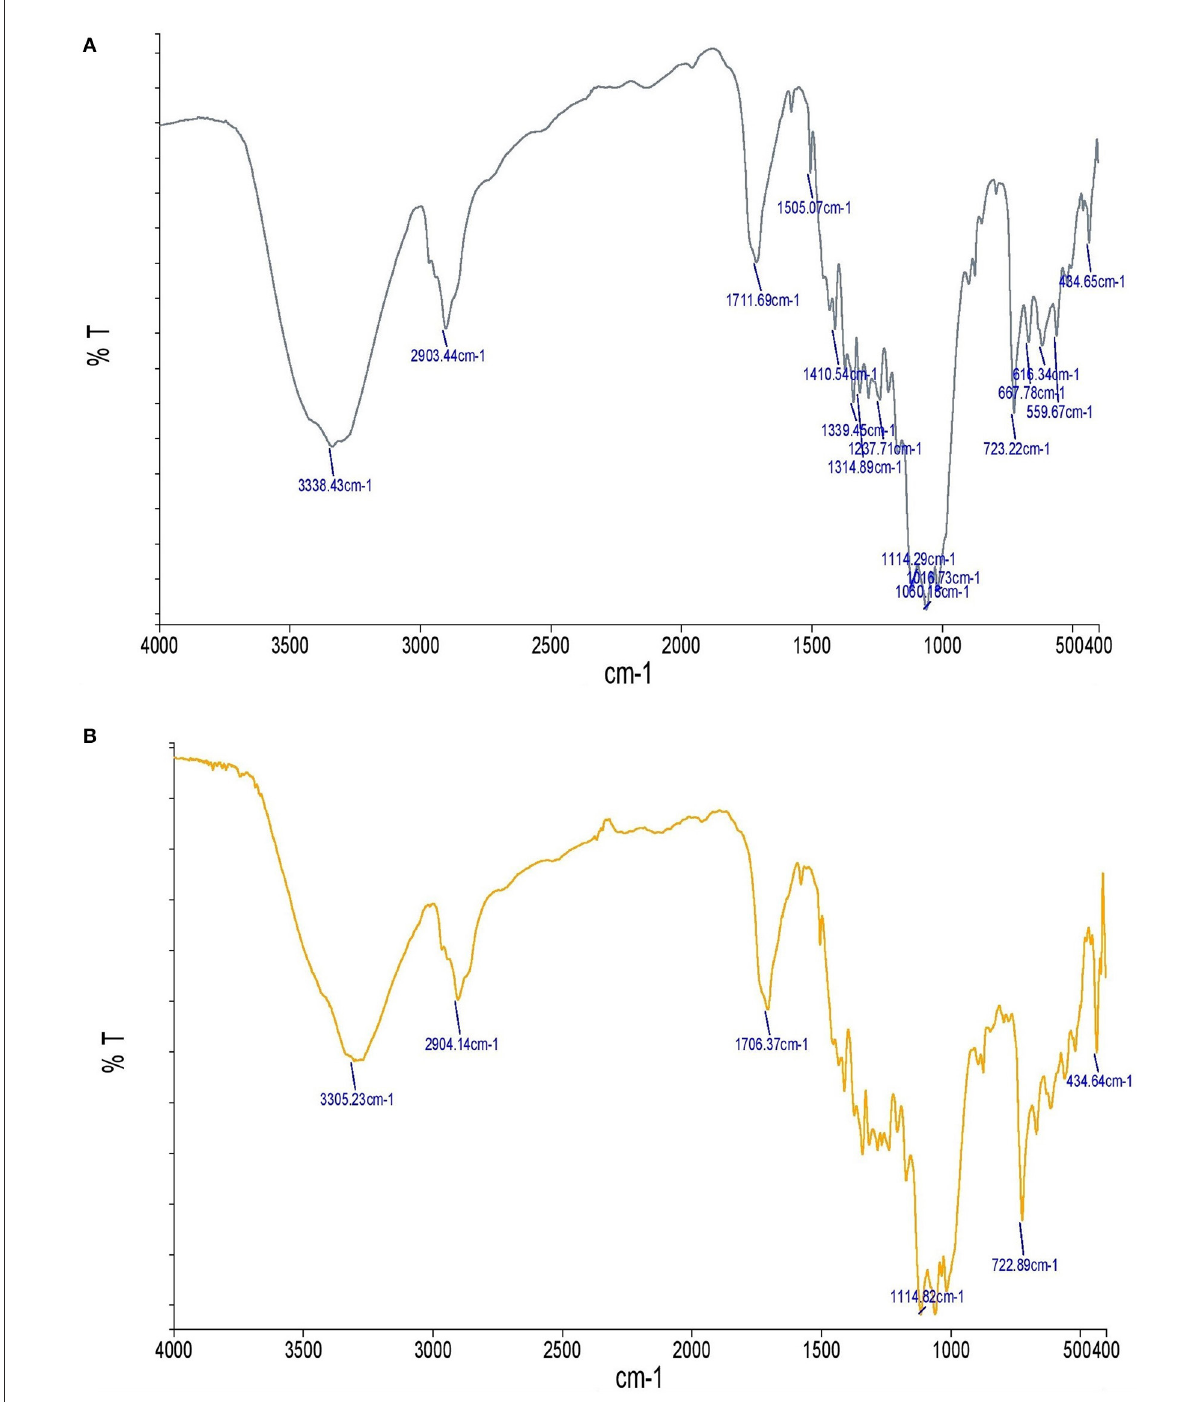
FIGURE4 FTIR spectra of uncoated fabric compared with the fabric coated with TiO 2 nanoparticles: (A) Uncoated fabric, (B) fabric coated with TiO 2 nanoparticles.